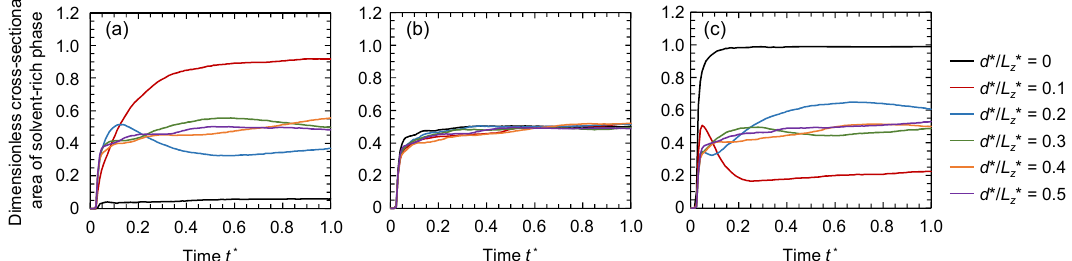
Figure 7. Time variations of the dimensionless cross-sectional area of the solvent-rich phase at different depths from the solid surface, d * / L z * = 0, 0.1, 0.2, 0.3, 0.4, and 0.5, for θ = ( a ) 50°, ( b ) 90°, and ( c ) 130°. surface corresponds to the surface porosity of the membrane. However, as described above, the cross-sectional area of the solvent-rich phase just below the surface should be considered as the surface porosity at high θ . Here, the dimensionless cross-sectional areas at the surface were considered as the surface porosity at θ = 50 ◦ , 70 ◦ , and 90 ◦ . At θ = 110 ◦ and 130 ◦ , the smallest cross-sectional areas along the z direction were considered as the surface porosity. The time variations of the surface porosities at various θ are shown in Figure 8. When the solid surface was highly compatible with the polymer ( θ = 50 ◦ ), the surface porosity was low because the polymer was concentrated at the surface. On the other hand, in the case of the low compatibility between the solid surface and the polymer ( θ = 130 ◦ ), the surface porosity was also low because the solvent was concentrated at the surface and the amount of solvent-rich phase just below the surface decreased (Figure 7c). phase and solvent-rich phase ( θ = 90 ◦ ), the highest surface porosity was achieved.